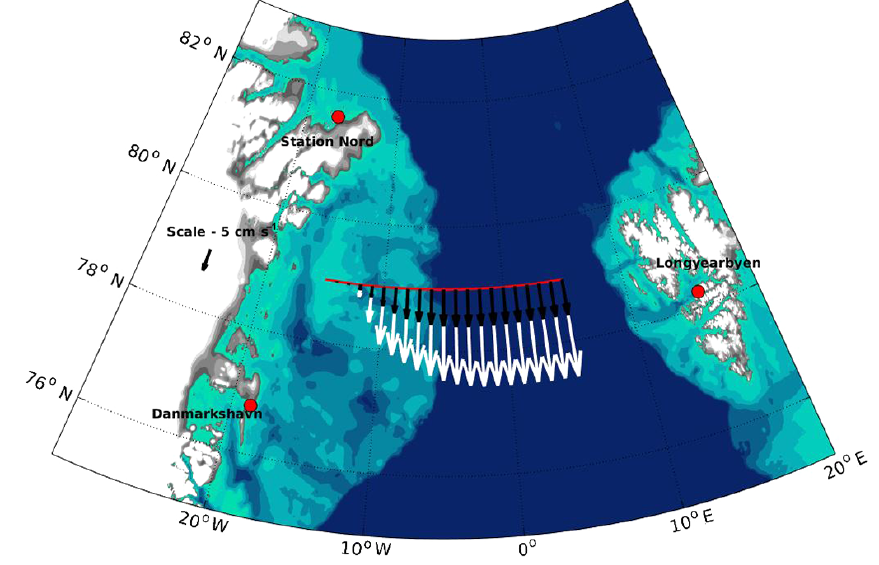
Figure 2. The Fram Strait between Greenland (left) and Svalbard (right) with summer (black arrows) and winter (white arrows) mean sea ice drift speed. Southward ice drift across 79 ◦ N (red line) from February 2004 to December 2014 were interpolated to 1 ◦ bins based on SAR imagery. Summer speeds are June–September means, while winter speeds are December–March means. Shades of blue show ocean bathymetry in 100m steps down to 500m depth. Red circles show locations for surface pressure observations on Svalbard (Longyearbyen) and Greenland (Station Nord and Danmarkshavn). Pressure observations were interpolated between the Greenland stations to calculate the mean pressure gradient along 78.25 ◦ N. Before 1958 pressure observations from Danmarkshavn are lacking, so observations from Tasiilaq (65.60 ◦ N, 37.63 ◦ W) were used, further south along the Greenland coast (Fig.